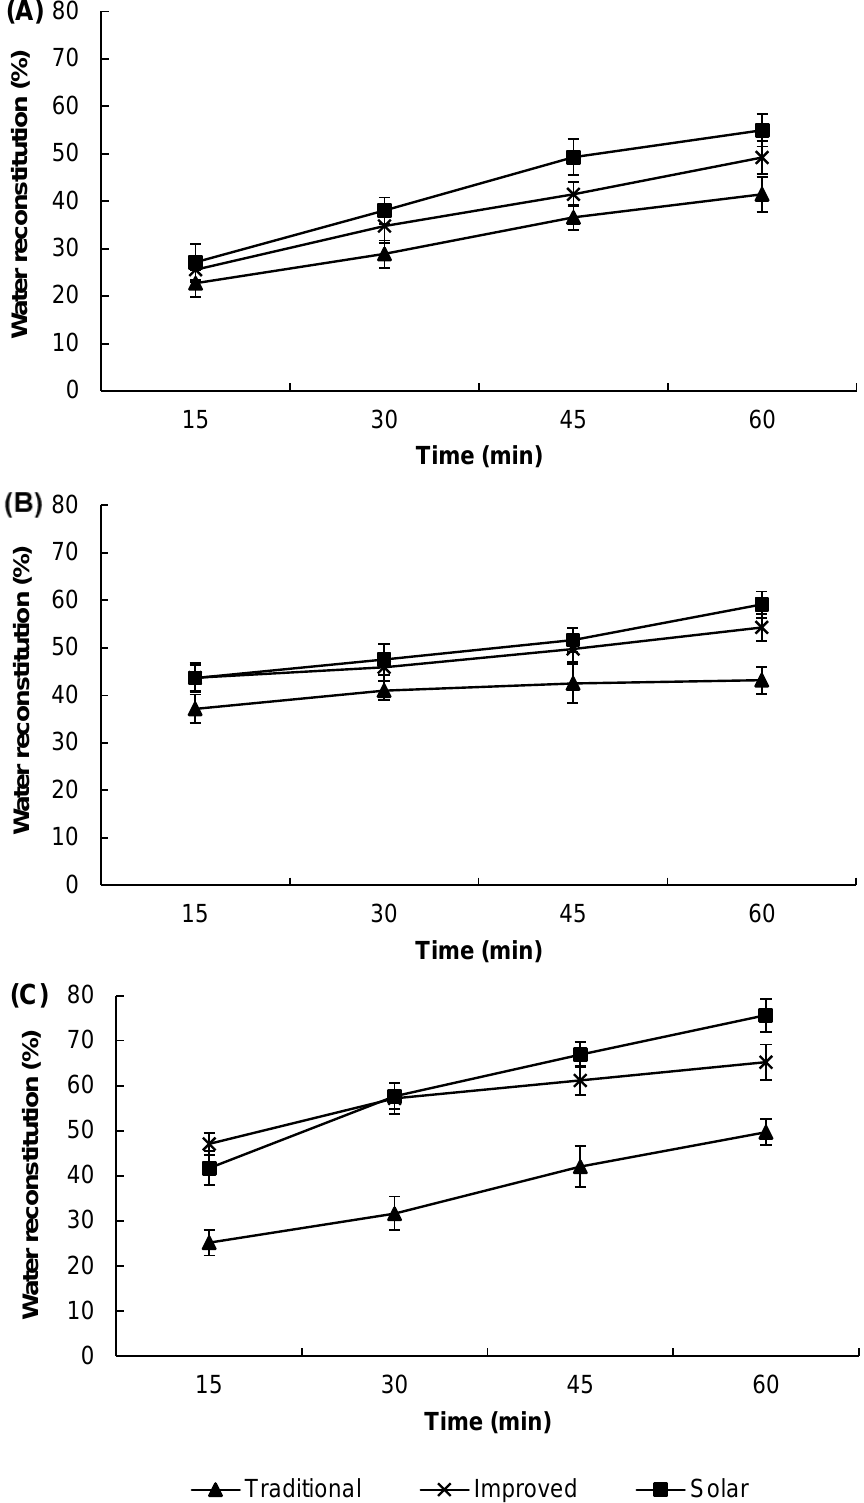
Figure 1. Water reconstitution of Hypophthalmichthys molitrix at ( A ) room temperature, ( B ) 40 °C and ( C ) 60 °C for the different drying methods.